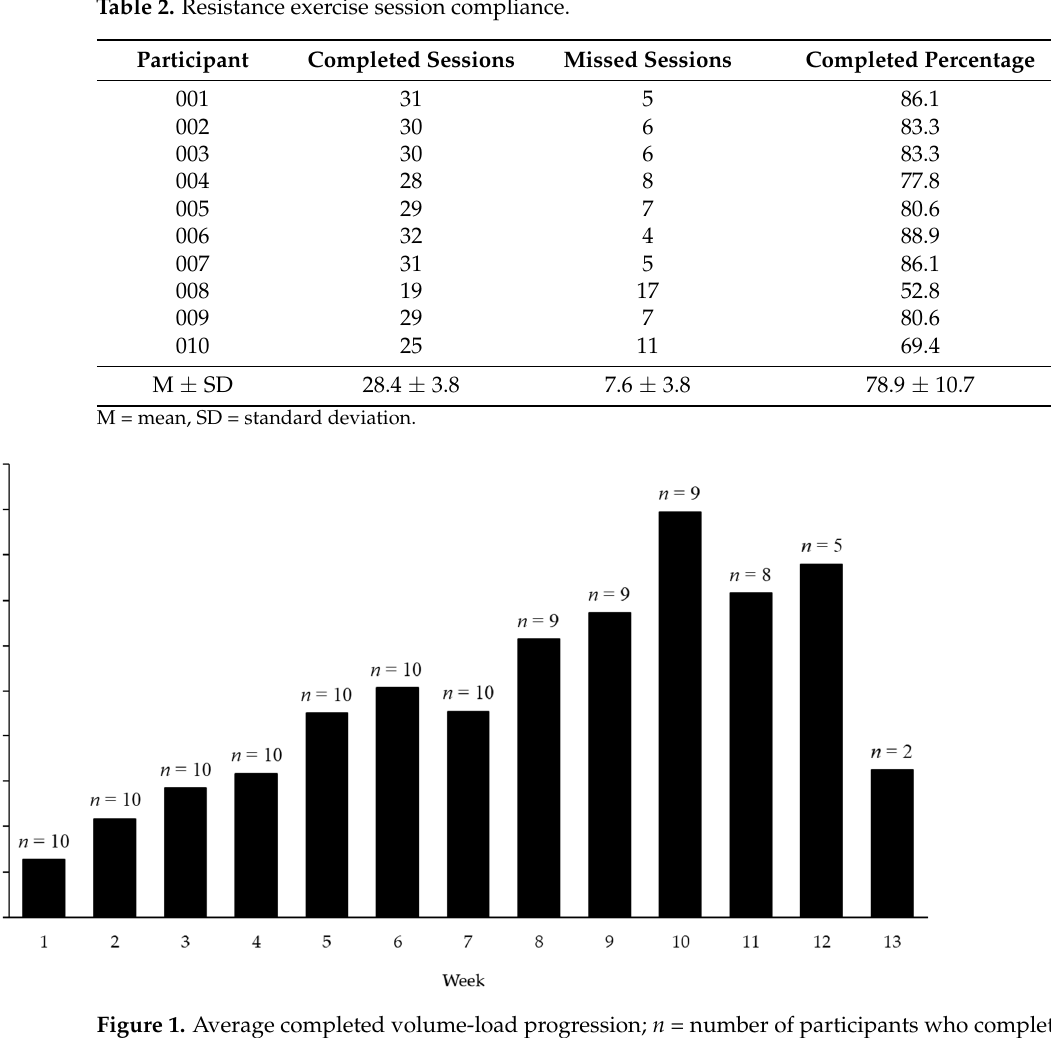
Figure 1. Average completed volume-load progression; n = number of participants who completed exercise sessions for that week.